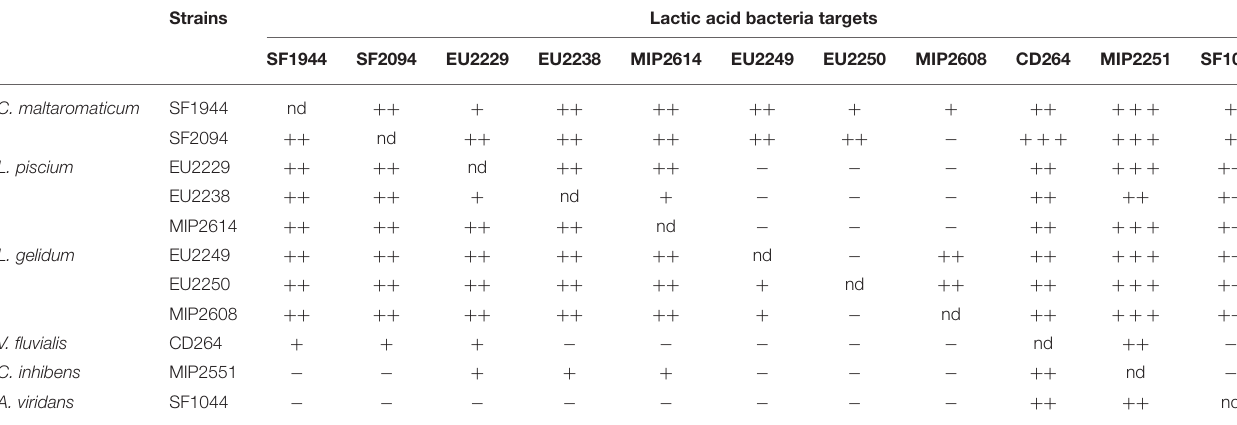
TABLE 4 | Protective cultures cross inhibition activity.